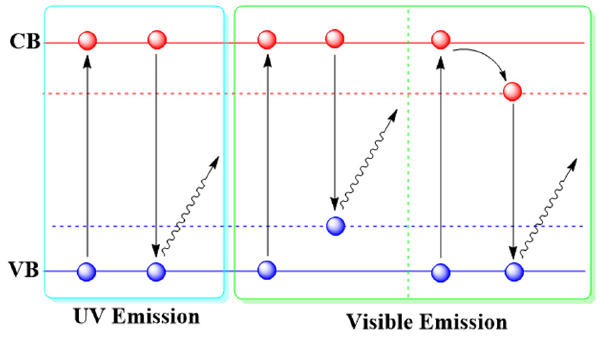
Figure 1. Schematic illustration of the main luminescent mechanisms for luminescent ZnO NPs. Note: valence band (VB); conductance band